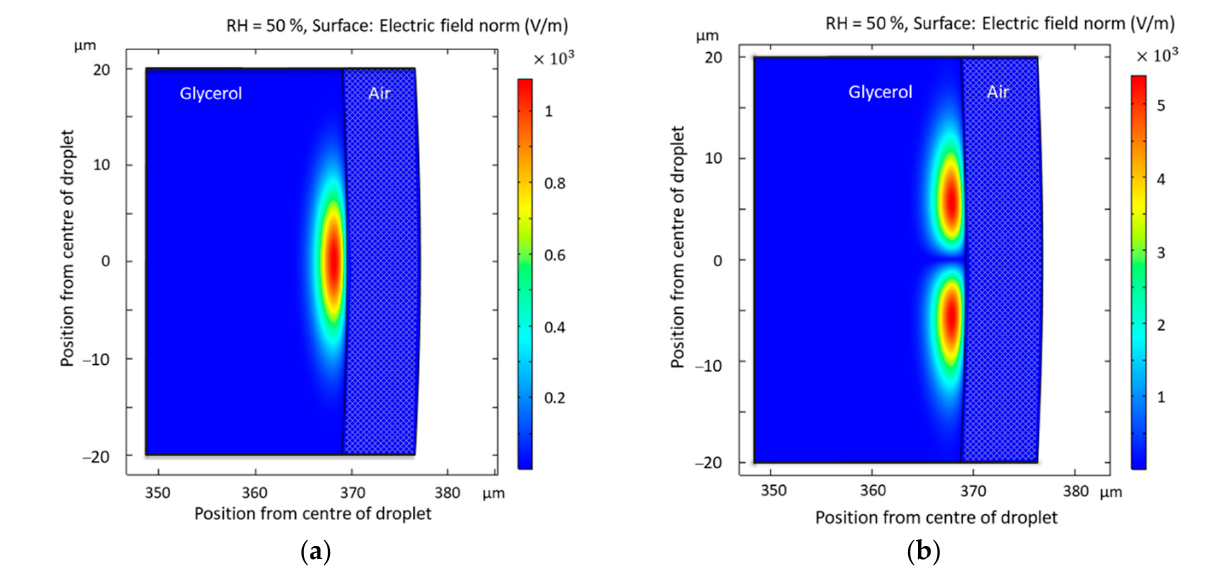
Figure 7. COMSOL simulations of whispering gallery modes in the glycerol droplet at 50% RH. Horizontal axis values